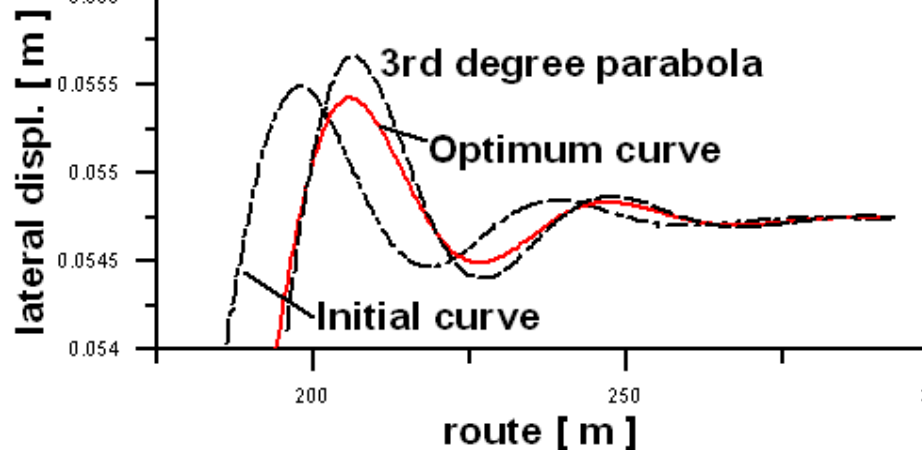
Figure 10. Lateral displacements for 11th degree (soft suspension v = 24.26 m/s 2 ).